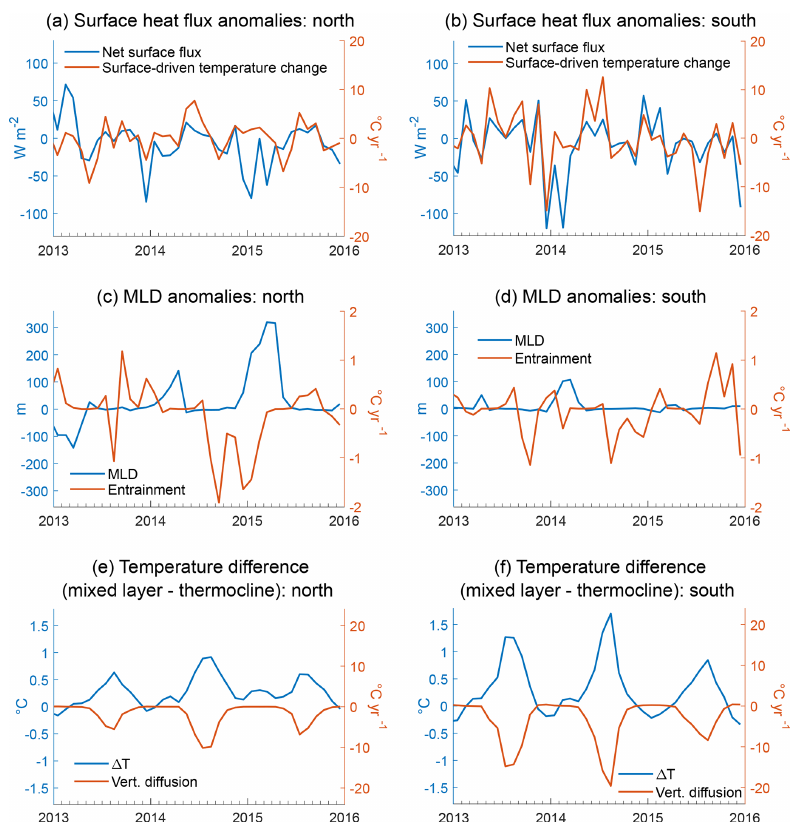
Figure B7. Time series of the individual components that comprise the dominant temperature budget terms and the associated change in mixed-layer temperature, both averaged over the north (a, c, e) and south (b, d, f) of the cold blob region in ECCOv4-r3. (a) Anomalies in the heat flux into the surface output by the model, defined as Q net in Eq. (1) (Wm − 2 ; blue), and anomalies in the associated change in mixed-layer temperature, i.e. the surface flux term of the mixed-layer budget ( ◦ Cyr − 1 ; red). (b) Anomalies in MLD (m; blue) and the associated entrainment term of the mixed-layer budget ( ◦ Cyr − 1 ; red). (c) The temperature difference between the mixed layer and the model cell immediately beneath ( ◦ C; blue), defined as (cid:49)T in Eq. (1), where positive values signify that the mixed layer is warmer than the thermocline, and the associated vertical diffusion term of the mixed-layer budget ( ◦ Cyr − 1 ; red). Note that the seasonal cycle has not been removed from either term in (e) – (f)